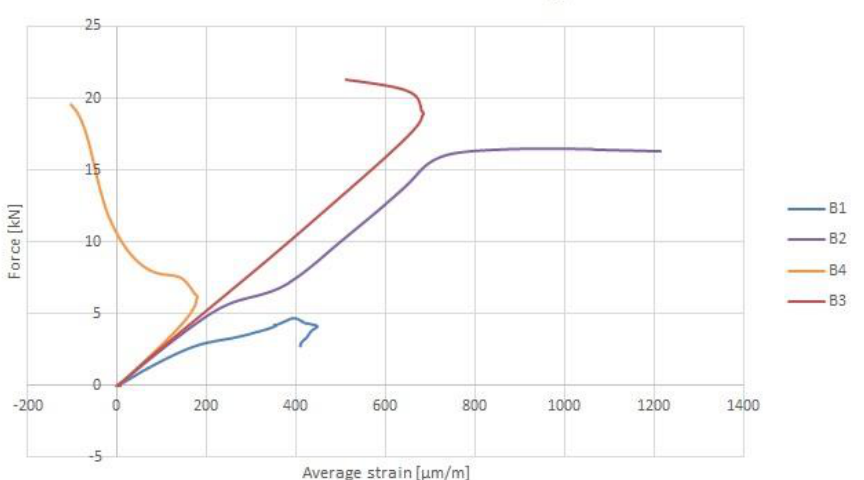
Figure 5. Force as a function of strain averaging. Results of strain gauge testing.